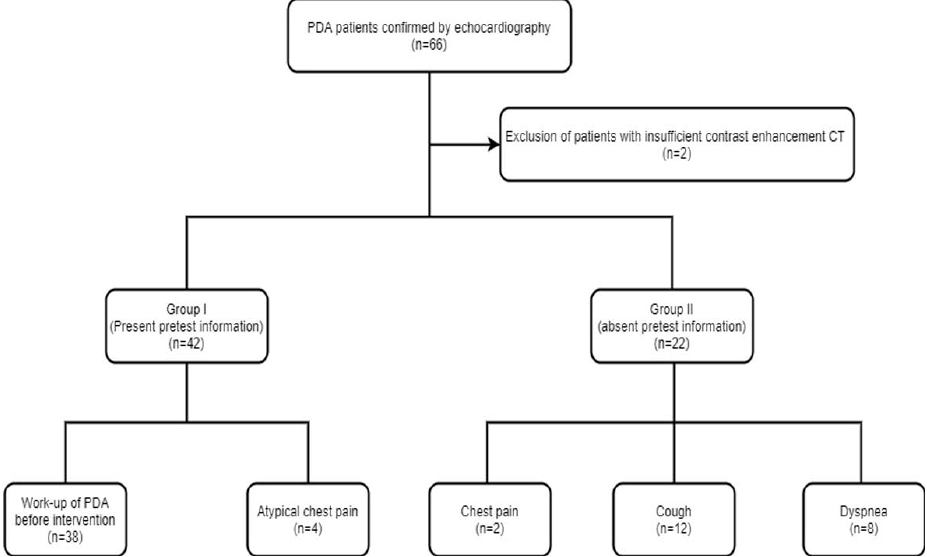
Figure 1. Flowchart showing the study design.